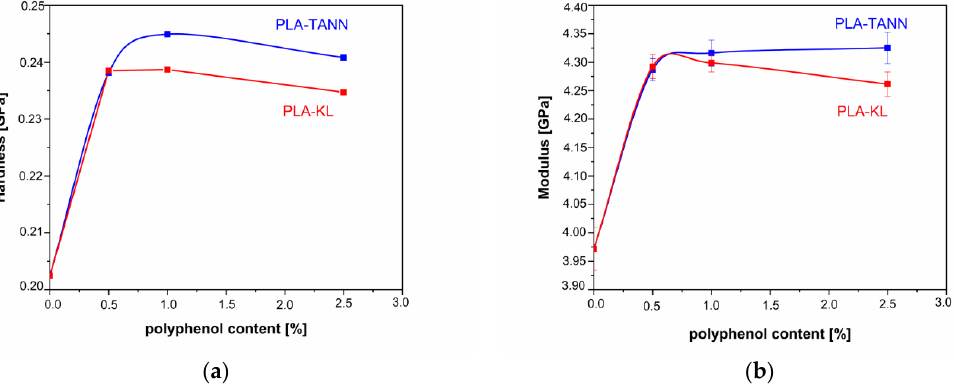
Figure 7. Nanoindentation hardness (a) and modulus (b) in respect to concentration of added poly-